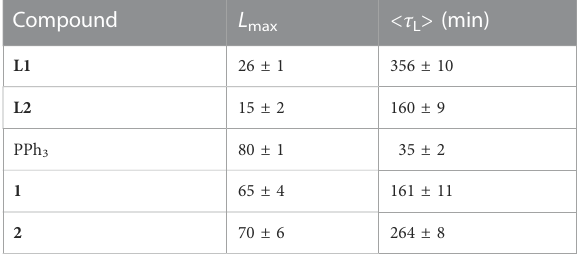
TABLE 2 DOPC membrane permeability parameters ( L max and < τ L > ) obtained for each compound through CF leakage (Eqs 15, 16) after fi tting Eq. 14 to the experimental results. (All values are the average ±standard deviation of at least 3 independent experiments). Compound